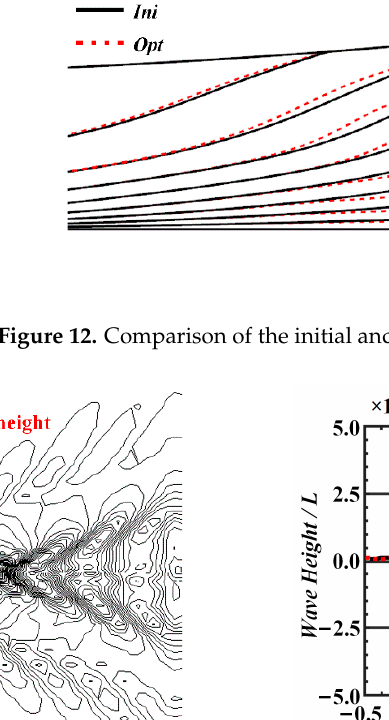
Table 6. Performance comparison of initial and optimized hull form.